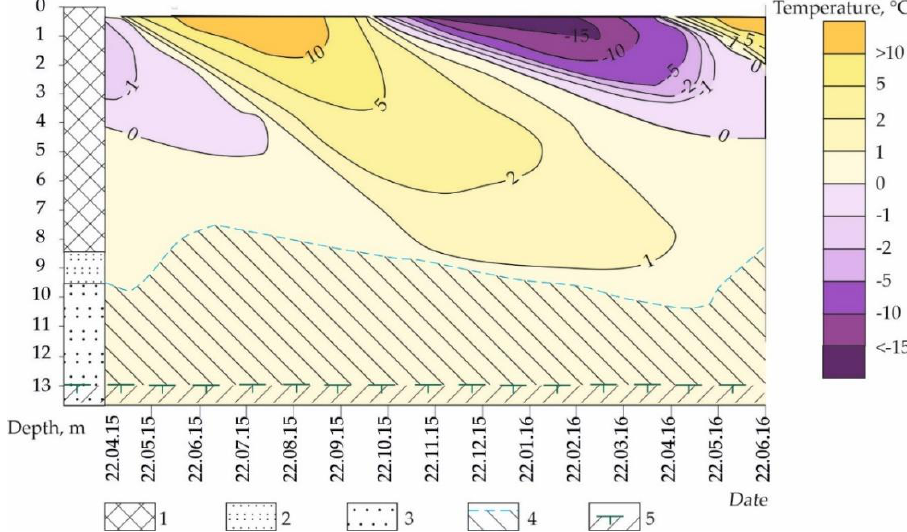
Figure 5. Variation in ground temperature and aquifer thickness on an annual basis (buried bar, borehole No 3). 1–3—soil lithology: 1—made ground (medium sand), 2–3—alluvial deposits: 2—silty sand; 3—fine sand; 4—aquifer; 5—permafrost table.